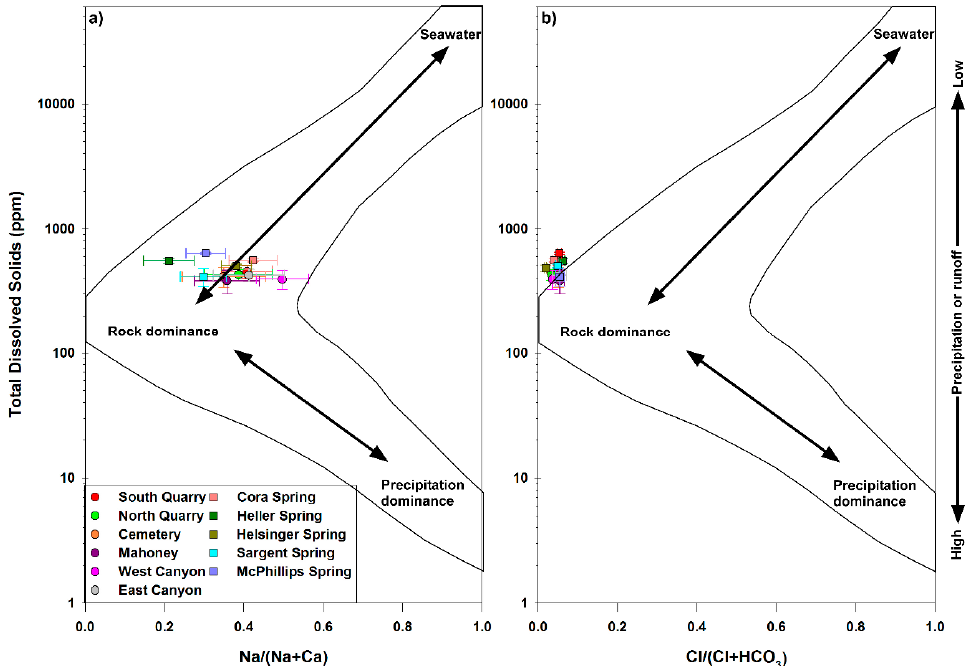
Figure 4. Gibbs diagrams identifying rock-water interaction as the dominant mechanism controlling the chemical composition of the waters. ( a ) Total dissolved solids (TDS) versus Na/(Na + Ca), ( b ) TDS versus Cl/(Cl + HCO 3 ). The lines serve as reference, defining the population of surface waters employed by Gibbs [53] . Samples plotting outside of the lines indicate chemistries that were not represented by the original population.